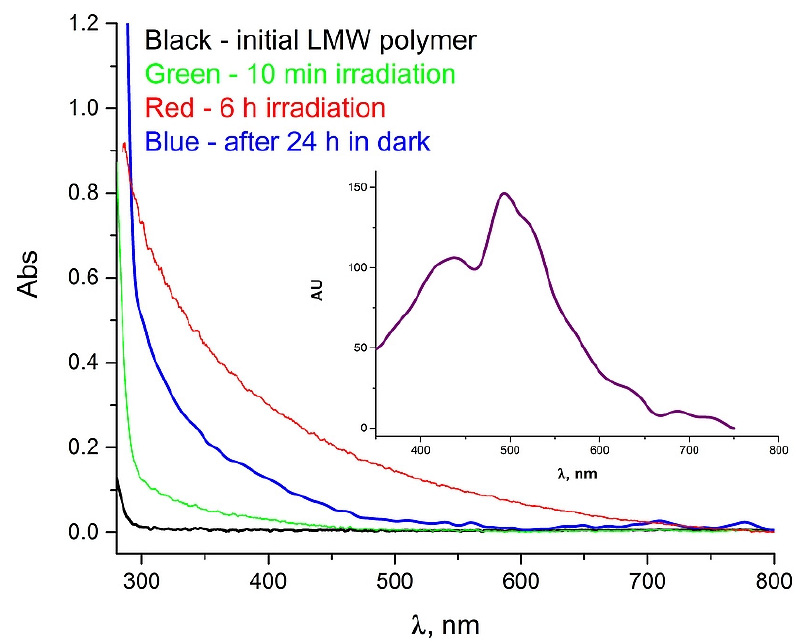
Figure 1. UV-Vis spectra of low-MW P4VP/Py gel samples in methylene chloride before and after irradiation at 312 nm as well as after holding the 6 h irradiated sample in the dark for 24 h. Inset: fluorescence spectrum of a thin film of a sample irradiated for 6 h (excitation at 350 nm).